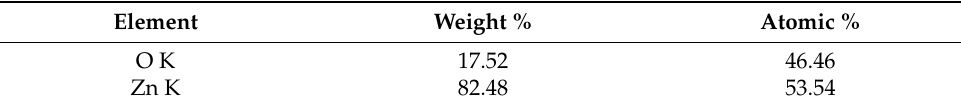
Table 1. Elemental analysis of energy-dispersive X-ray spectroscopy (EDX).